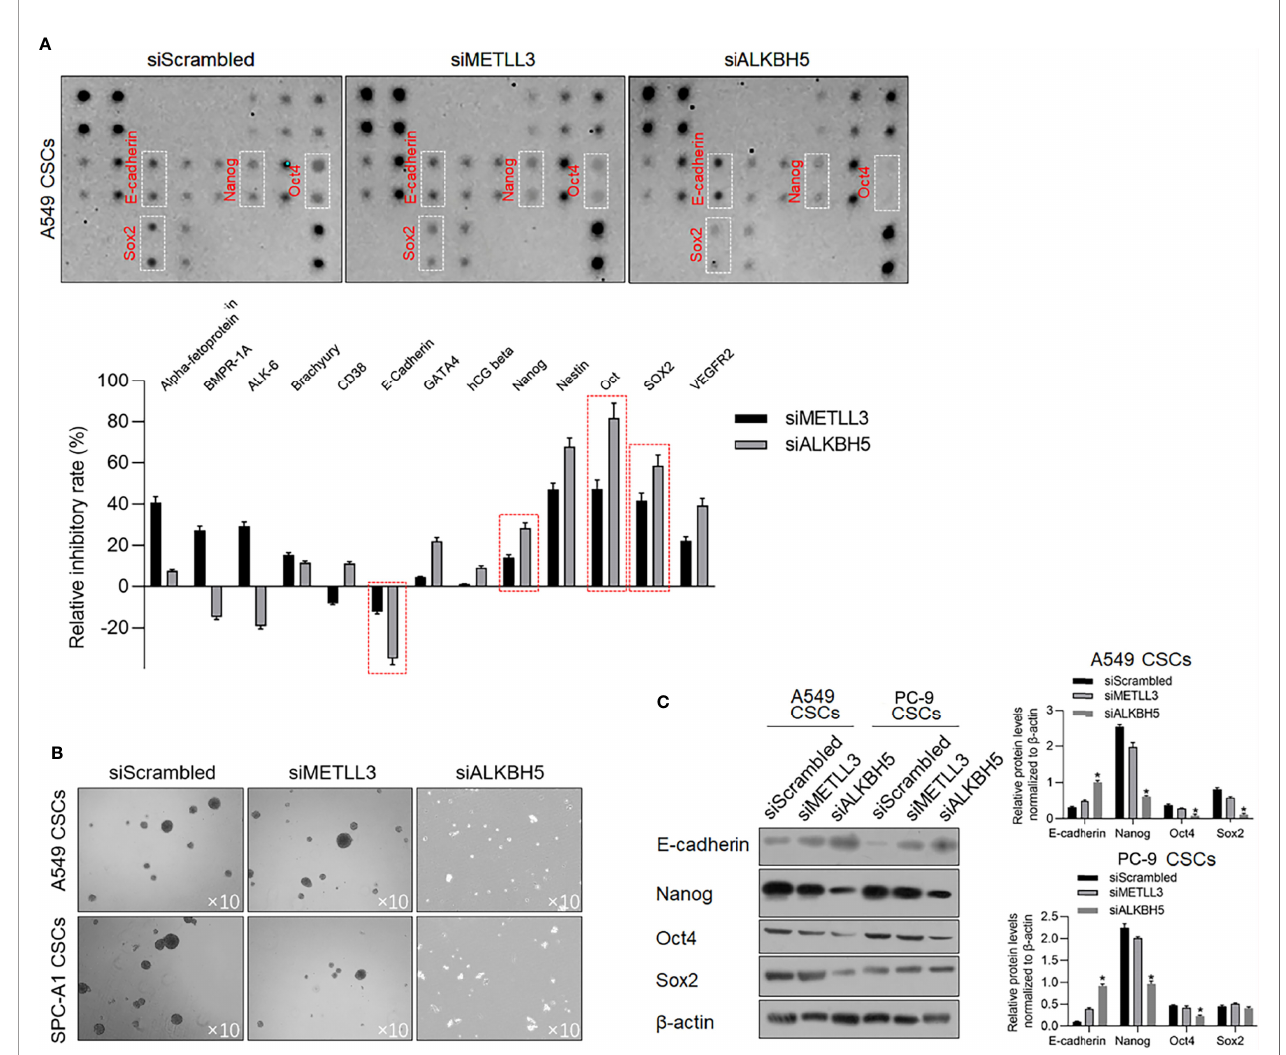
FIGURE 5 | ALKBH5 knockdown increased E-cadherin and decreased stemness. (A) To detect the changes of human stem cell hallmarkers after ALKBH5 knockdown, a human stem cell antibody array was performed. (B) After METTL3 or ALKBH5 knockdown, sphere formation was measured. (C) To con fi rm the effects of METLL3 or ALKBH5 knockdown on E-cadherin, Nanog, Oct4, and Sox2, a Western blot analysis was performed. * p < 0.05 vs.